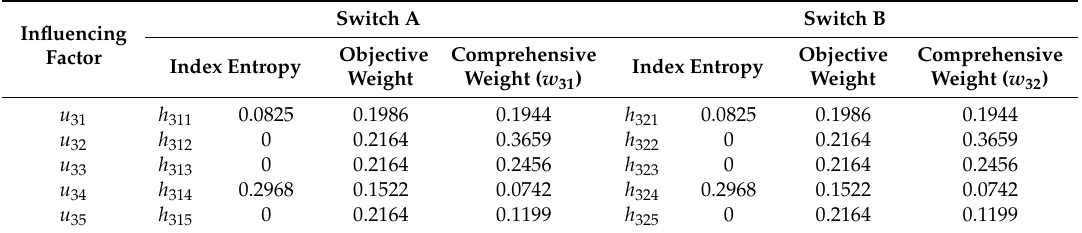
Table 18. The objective and comprehensive weights of the influencing factors of Switch A and Switch B.